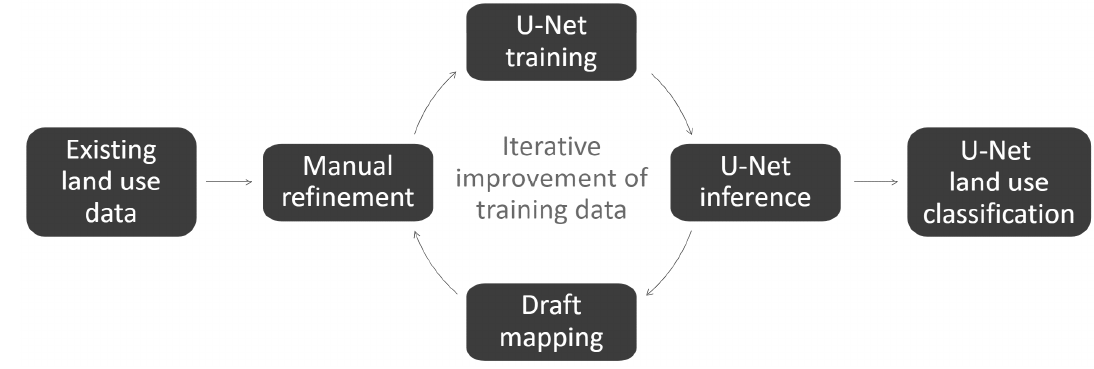
Figure 3. The training–inference–refinement iteration loop.